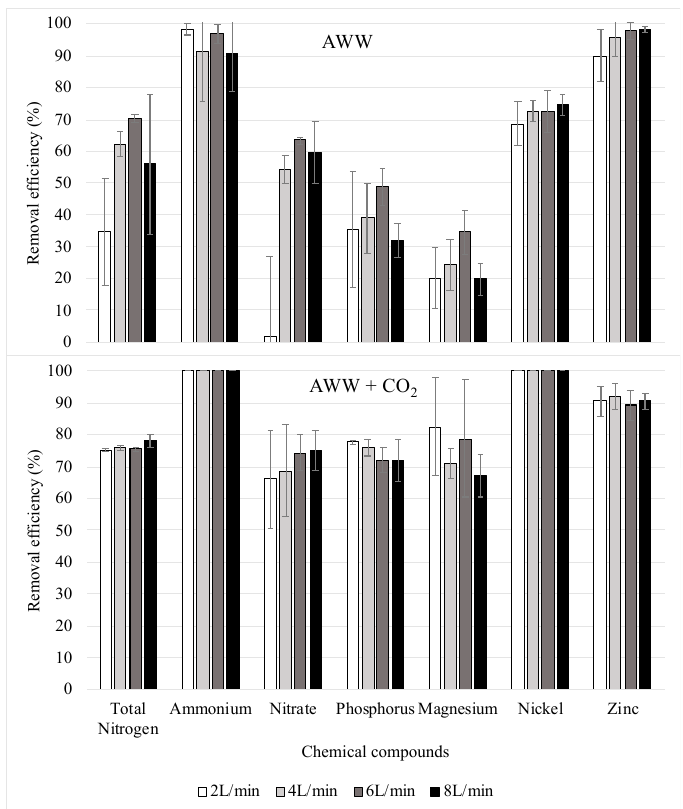
Figure 5. Percentages and standard deviations of nutrients depleted by the C. sorokiniana cultivated in two different conditions: AWW = AWW air-lifted with pure air; AWW + CO 2 = AWW air-lifted with CO 2 -enriched air. Four different airflow rates were tested in each group (2, 4, 6, and 8 L/min). Number of samples per treatment = 3.